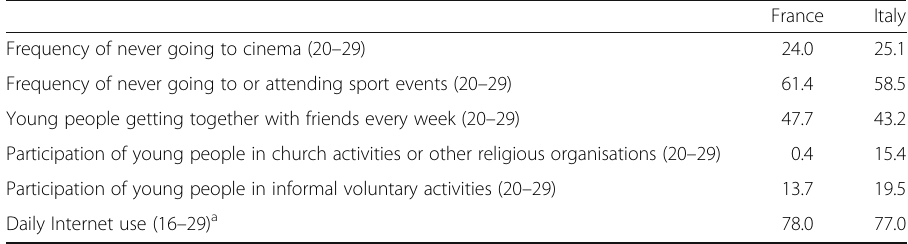
Table 10 Indicators concerning youth culture in France and Italy in 2006